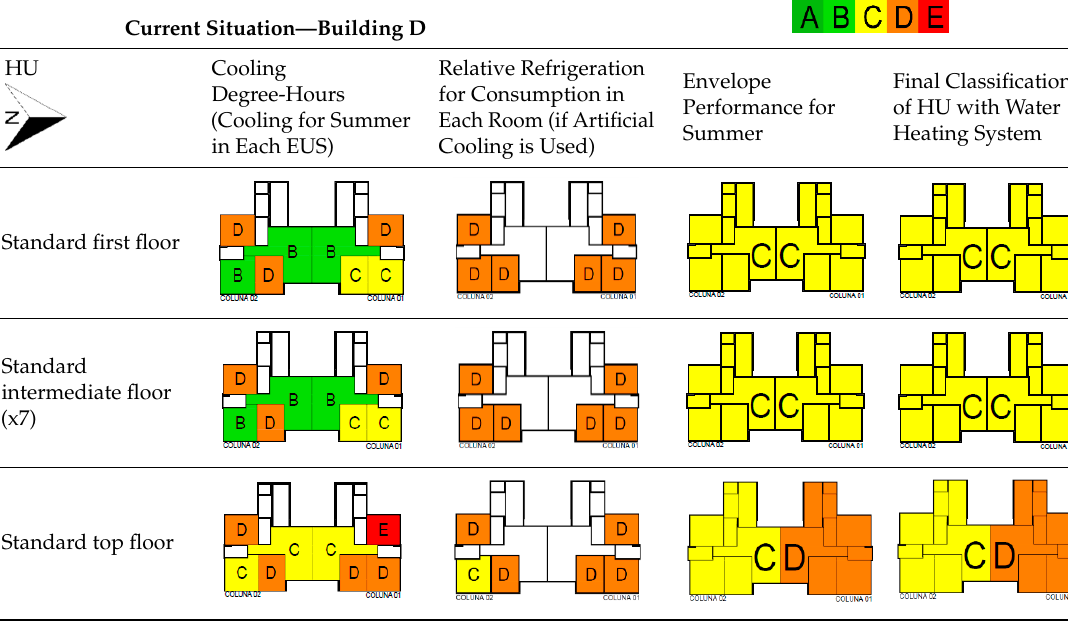
Table 8. Graphical representation of the standard floor of Representative Building D with the classification based on energy efficiency evaluation.